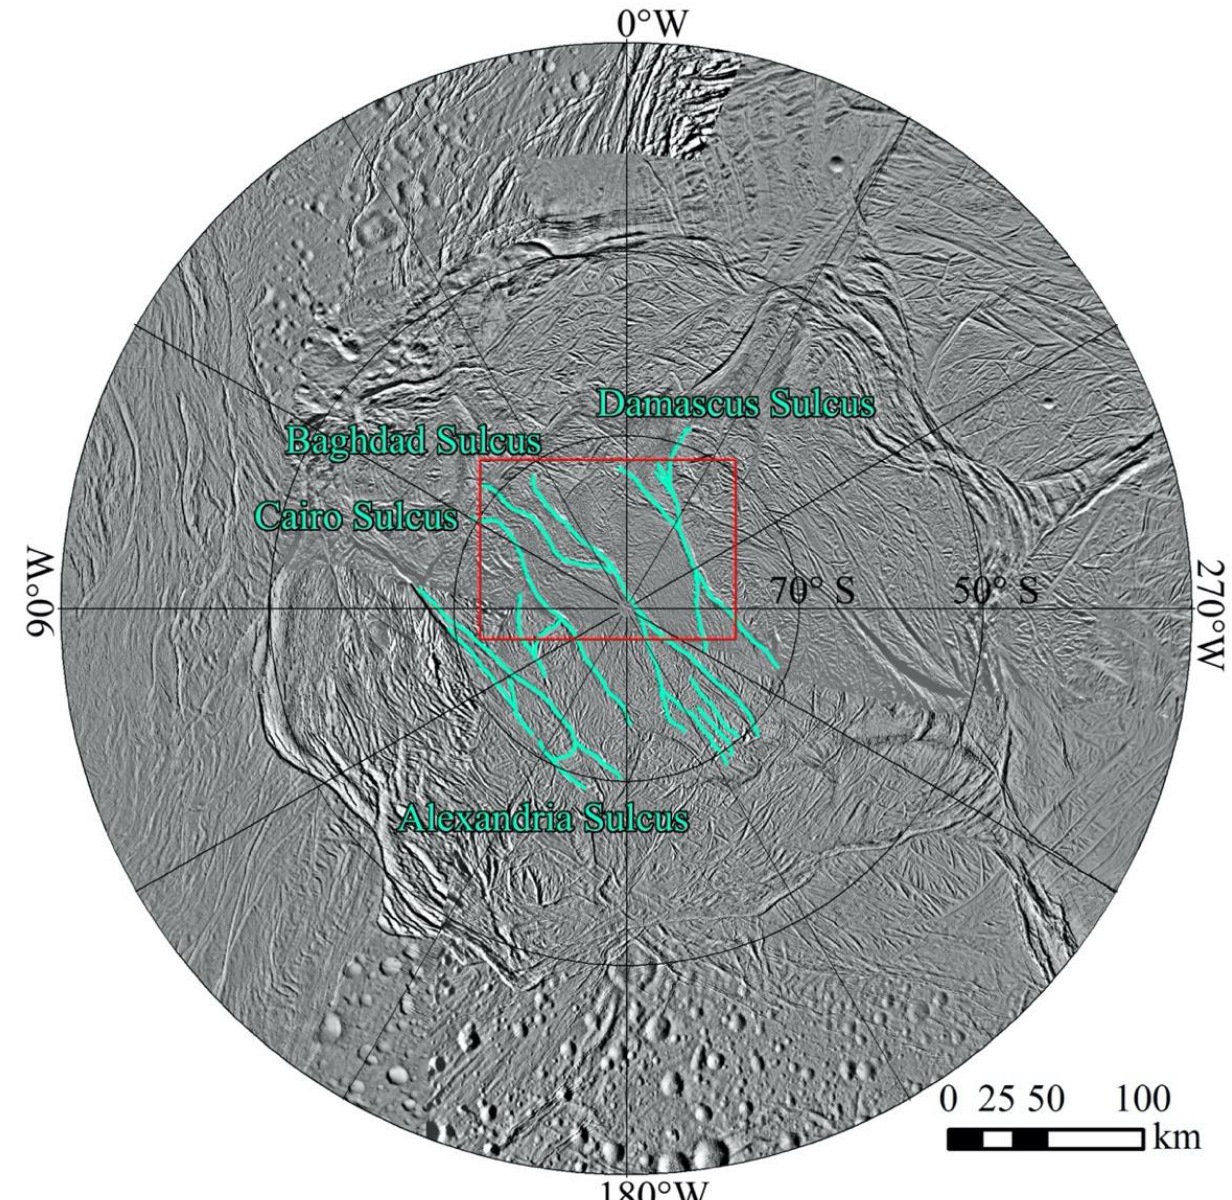
Figure 1. Polar stereographic map of Enceladus southern hemisphere. The four main TS Damascus, Baghdad, Cairo and Alexandria Sulci are highlighted in light blue, following Crow-Willard and Pappalardo [7]. The red rectangle shows the location of our study area, presented in Figure 2.